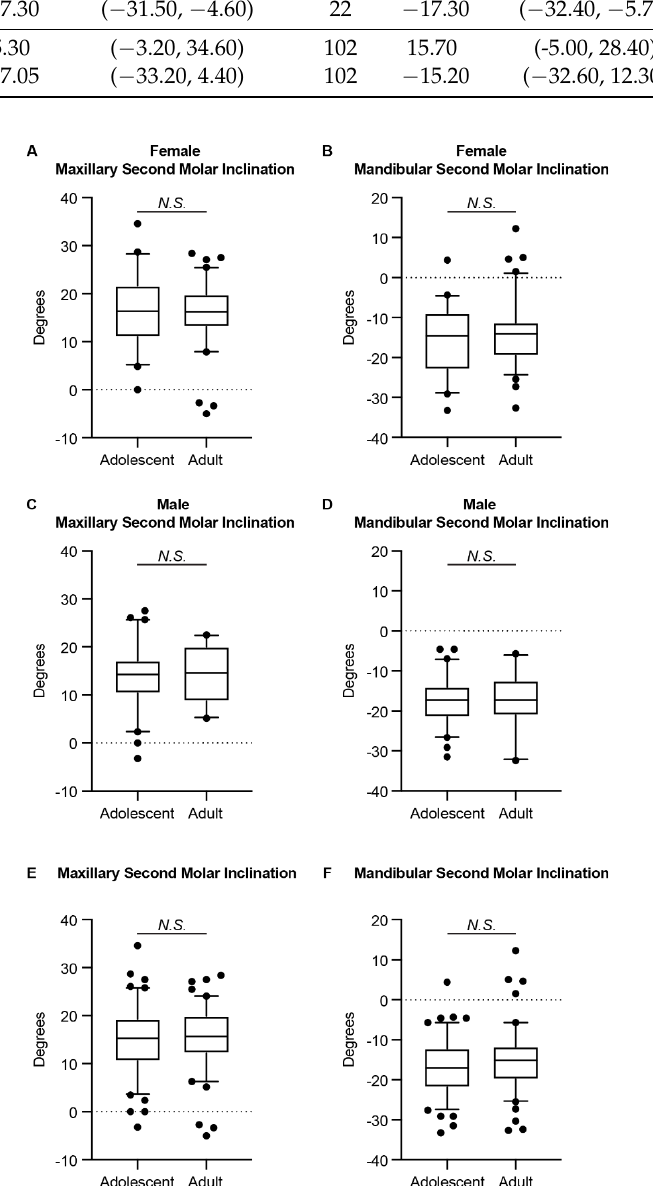
Figure 4. The comparison of the second molar inclination between age groups. The ( A ) maxillary and ( B ) mandibular second molar inclination of females in the adolescent and adult groups. The ( C ) maxillary and ( D ) mandibular second molar inclination of males in the adolescent and adult groups. The ( E ) maxillary and ( F ) mandibular second molar inclination of both genders in the adolescent and adult groups. The Mann – Whitney U test was used. The box plot represents the 5th percentile, 25th percentile, median (50th percentile), 75th percentile, and 95th percentile, respectively. N.S.: not significant.